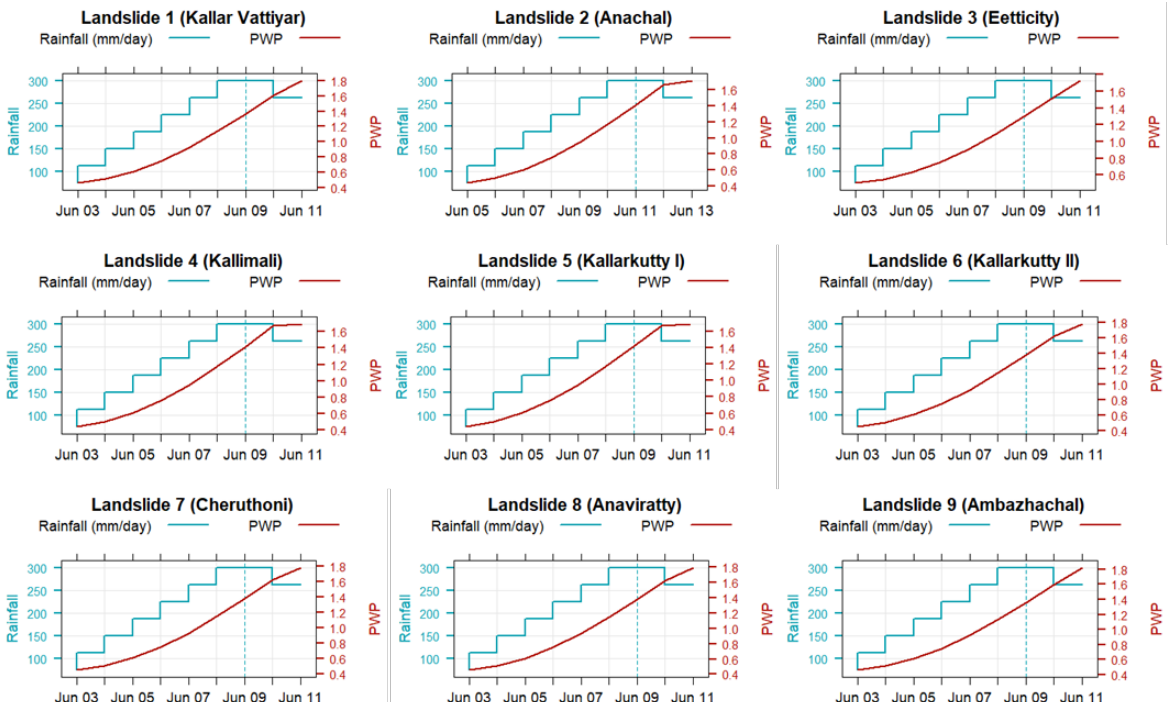
Figure 14. Comparison of the rise in PWP (porewater pressure) with respect to rainfall, from the outputs of nonoptimized and optimized model runs at 9 validation sites. The vertical dotted black line indicates the day on which the landslide was triggered.